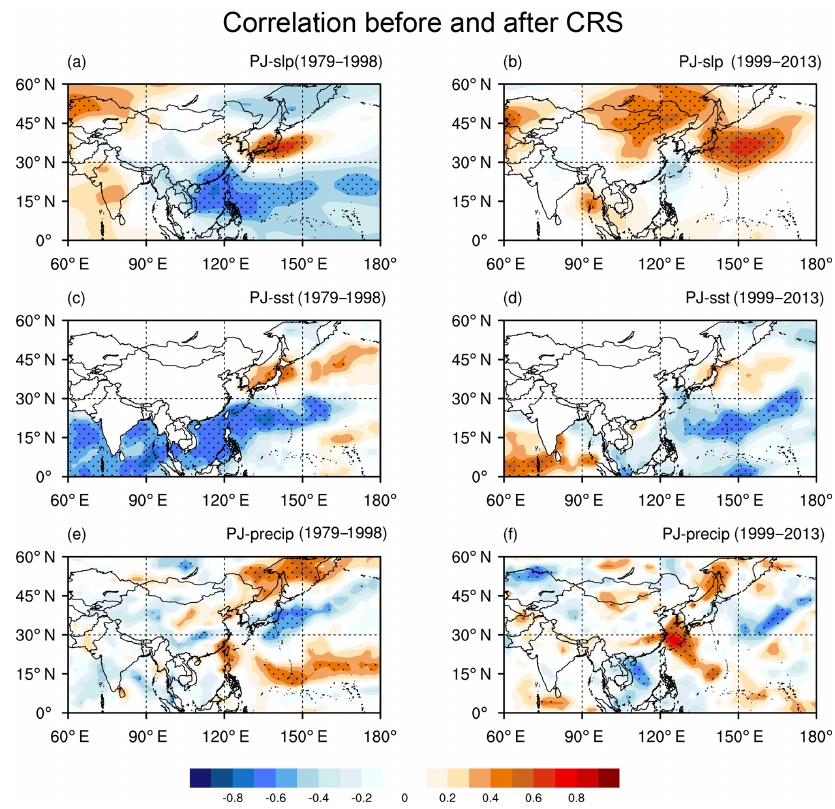
Figure 6. Correlation maps of the PJ index before (a, c, e) and after (b, d, f) the year 1999. The top, centre, and bottom panels are PJ vs. SLP, PJ vs. ERSST, and PJ vs. GPCP data, respectively. Correlation values at a 5% significance level are